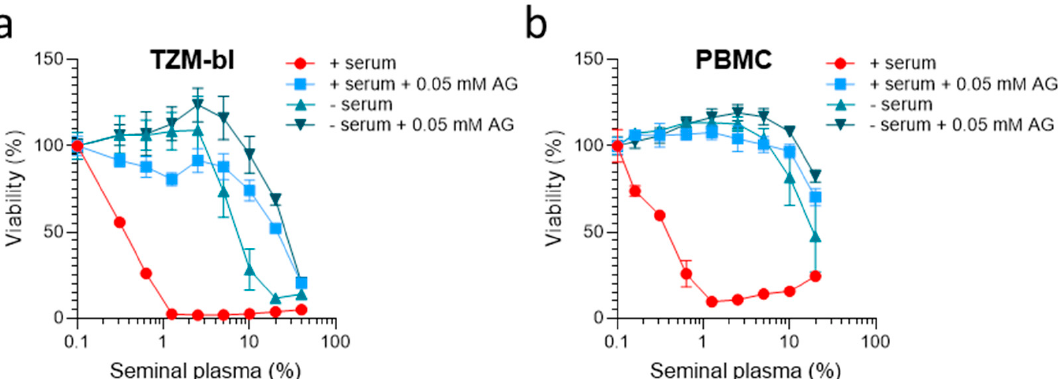
Figure 4. Aminoguanidine combined with serum-free medium prevents seminal plasma-derived cytotoxic effects. ( a , b ) The TZM-bl (2 × 10 3 ) cells ( a ) or PBMCs (1 × 10 5 ) ( b ) were treated with the indicated amounts of SP in the presence of growth medium supplemented with 10% FCS, growth medium supplemented with 10% AG-treated FCS (pretreatment with 0.5 mM AG), a chemically- defined, serum-free medium, or a chemically-defined, serum-free medium supplemented with 0.05 mM AG. Viability was determined after 2 days by MTT assay ( a ) or 3 days using CellTiter-Glo™ assay ( b ). Data shown are average % values derived from one representative experiment performed in biological triplicates ± SD.